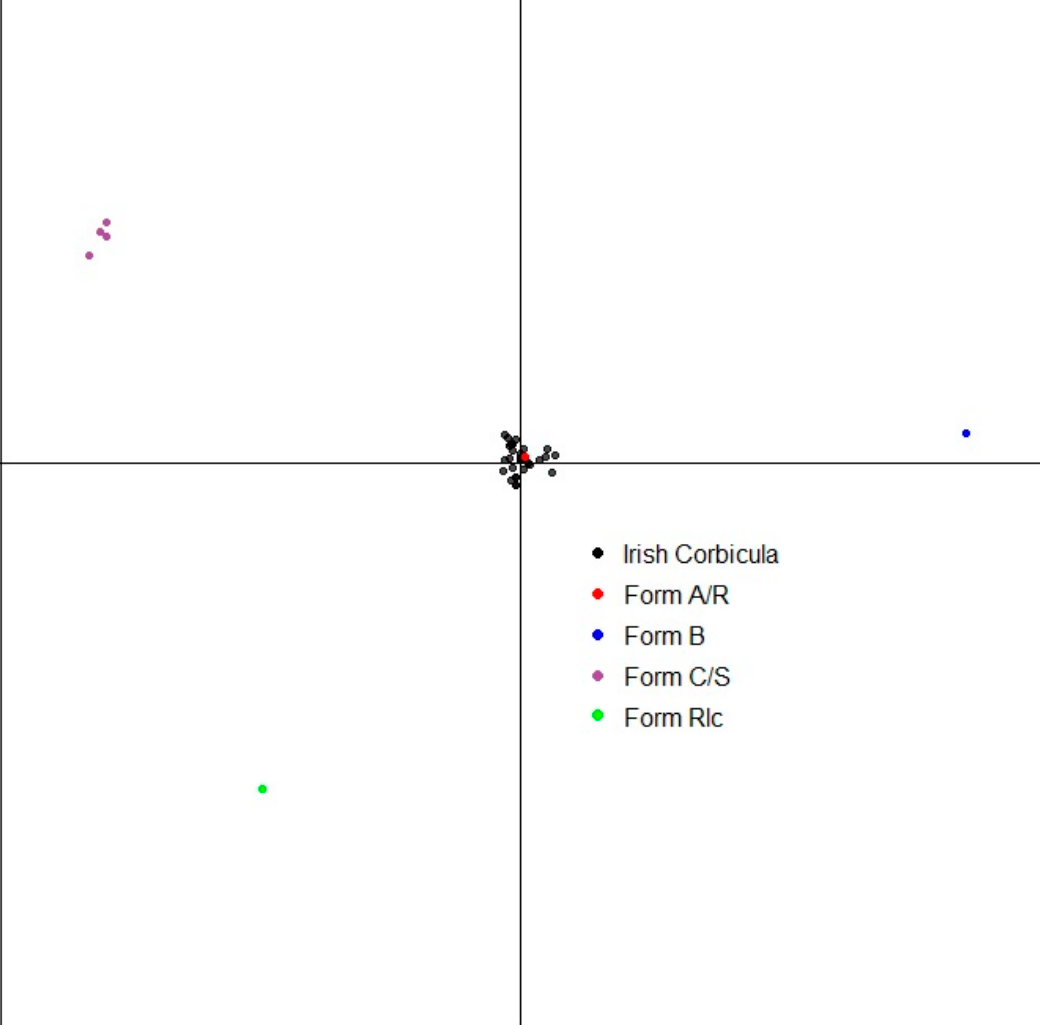
Figure 5. Genetic diversity and genetic relationships in invasive Corbicula clams estimated through a Discriminant Analysis of Principal Components based on multilocus genotypes. Only axes 1 and 2 are represented. One dot represents one distinct multilocus genotype; individuals showing the exact same genotype are, therefore, pictured under the same dot.